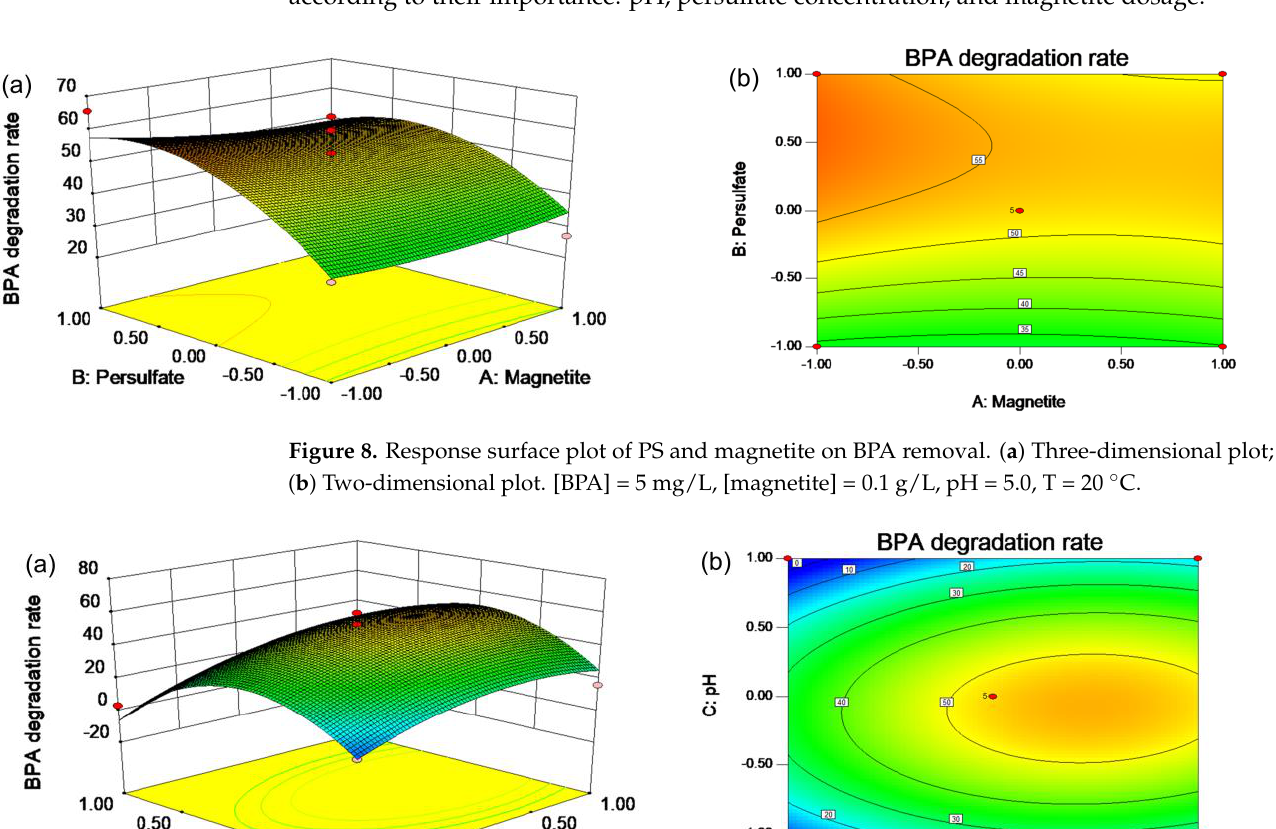
Figure 10. Response surface plot of pH and magnetite on BPA removal. (a) Three-dimensional plot; (b) Two-dimensional plot. [BPA] = 5 mg/L, [PS] = 0.2 mM, T =20 °C. Figure 11 shows the prediction plot of optimized conditions for BPA degradation. The optimal reaction conditions obtained from the software analysis were: 0.3 g/L of mag- netite, 0.26 mM of PS, and pH 4.9. The predicted BPA degradation under optimal condi- tions was 59.54%. The actual BPA degradation rate was 65.52% (0.3 g/L of magnetite, 0.3 mM of PS, pH 5.0). This indicated that the optimal reaction conditions were more reliable. Figure 11. Optimization of experimental conditions.